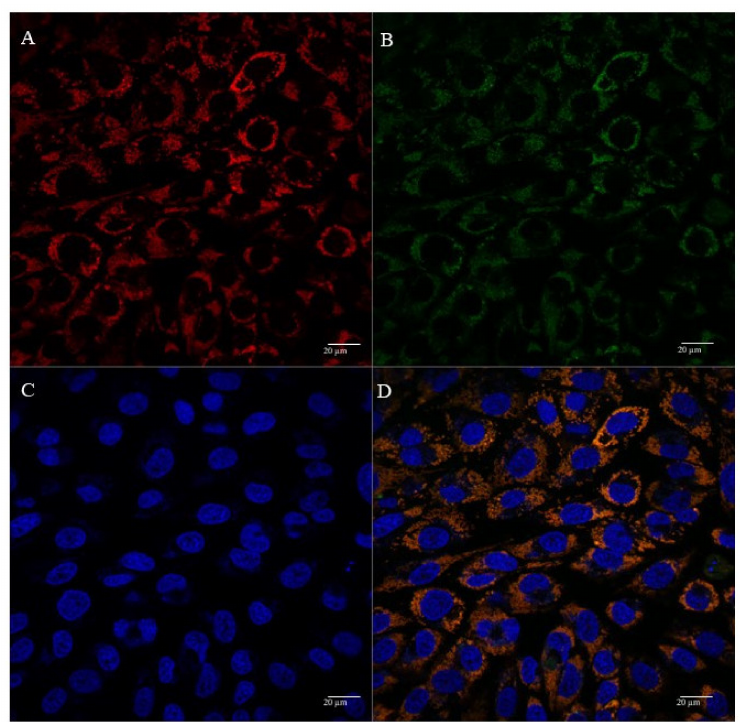
Figure 7. Representative confocal fluorescence image of HeLa cells, illustrating the transfection ability and intracellular co-localization of MTS-WRAP1/pND1 complexes formulated at an N/P ratio of 5. Mitochondria stained red by MitoTracker ( A ), pND1 green, labeled ( B ), nucleus marked blue by DAPI ( C ), and merged image ( D ). Scale bar = 20 µ m.